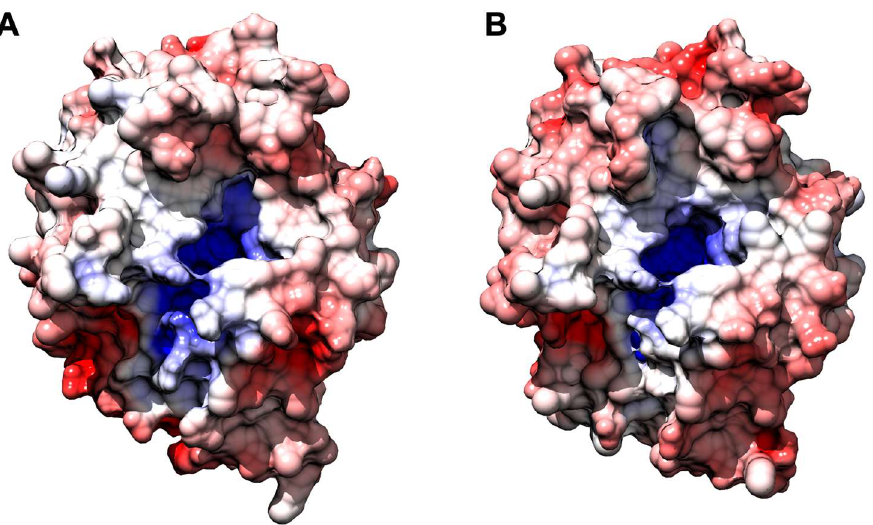
Figure 6. Comparative analysis of surface charge distribution calculated at 150 mM NaCl, pH 8.0, and 310 K. An OYE2 is on the left ( A ), and Bf OYE1 is on the right ( B ). Density of negative potential is red, positive is blue, and neutral is white.